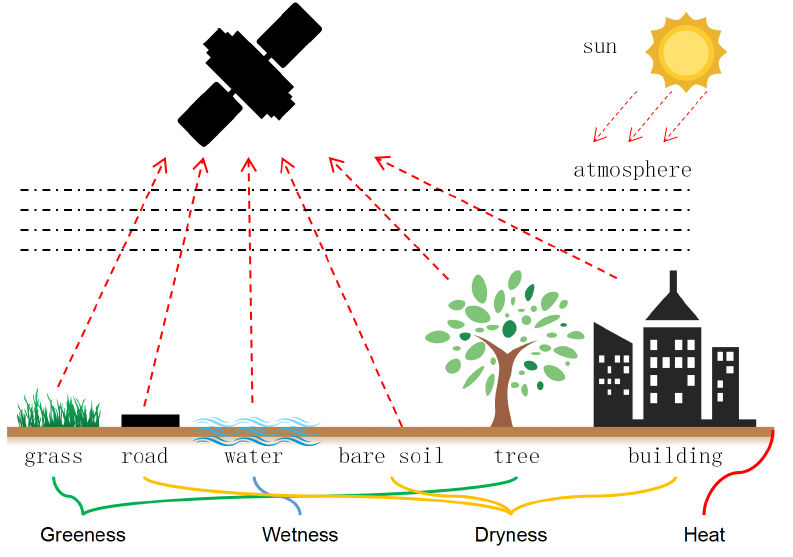
Figure 1. Schematic view of remote